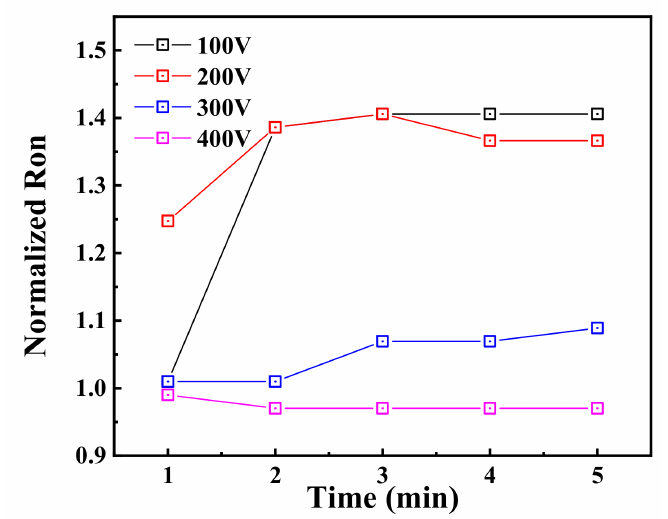
Figure 4. Normalized R ON value for increasing stress times with the interval of 60 s at off-state voltage from 100 to 400